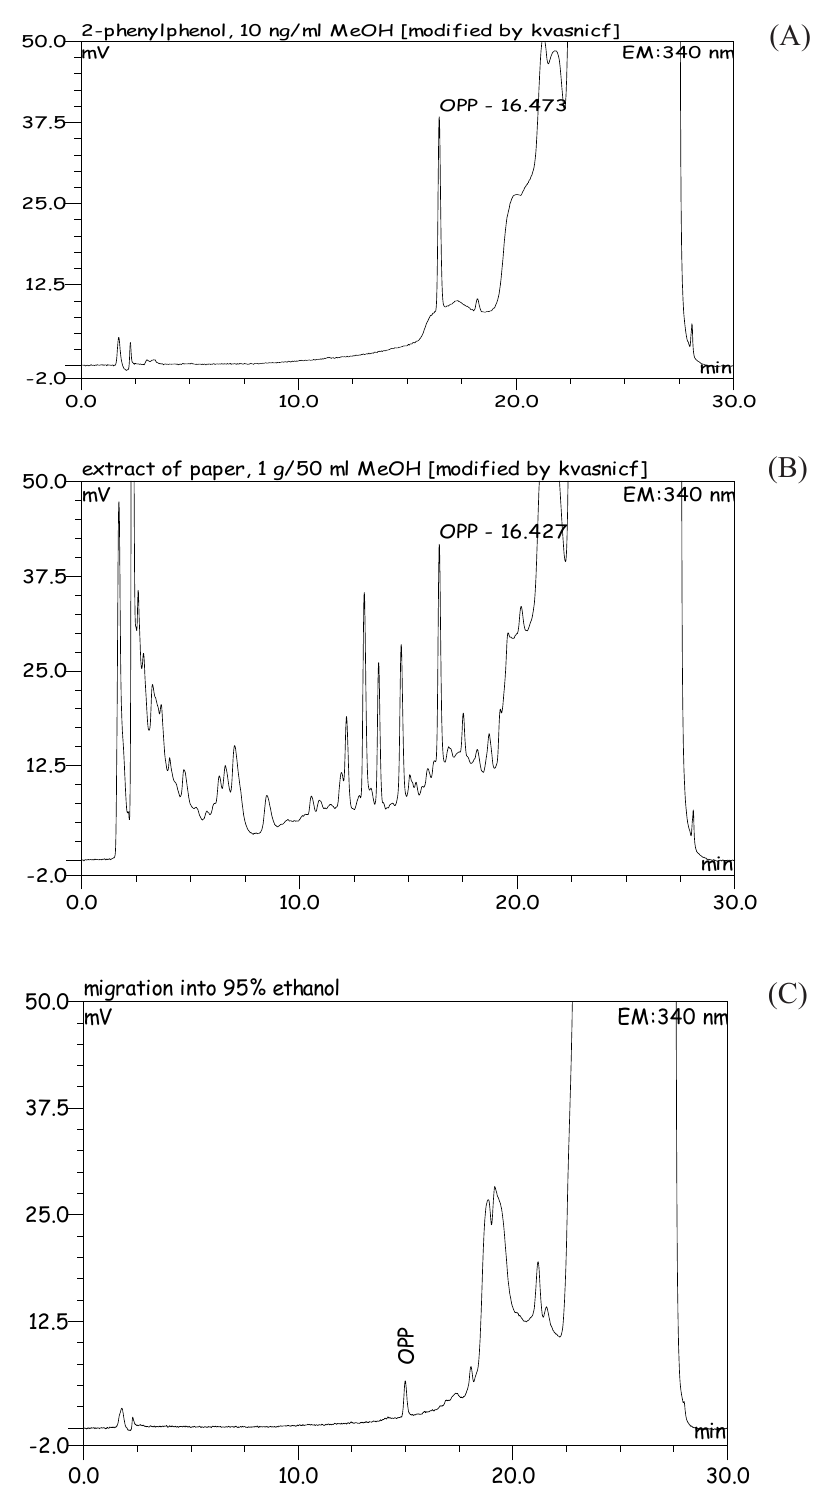
Figure 1. Examples of typical chromatograms; (A) analysis of OPP standard solution (10 ng mL -1 ), (B) paper extract (sample No 22, 1 g/50 mL of methanol), (C) migration of OPP from the sample No 22 into 95%